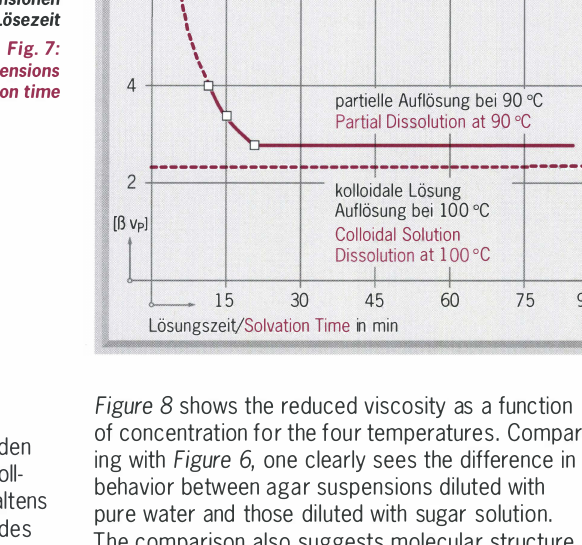
Flow behavior of aqueous agar